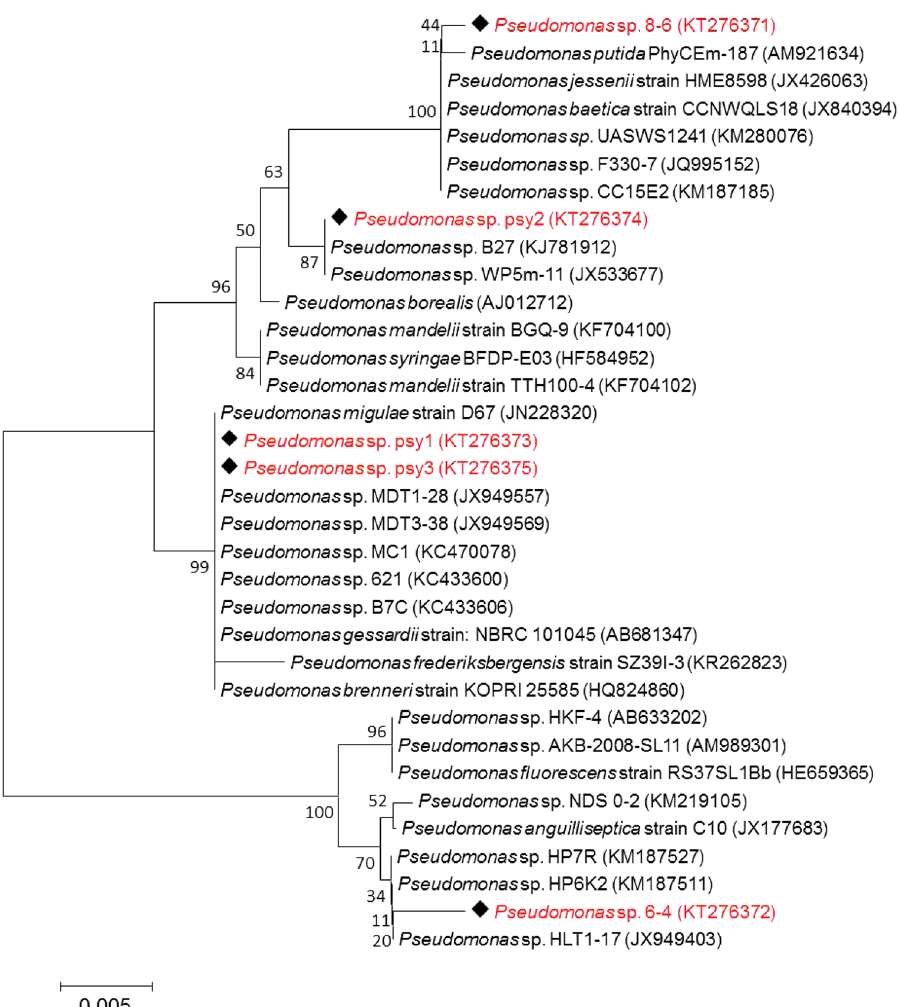
Figure 2. Neighbor-Joining (NJ) bootstrapping (100) phylogenetic tree of arctic glacier soil Pseudomonas spp. and their closest NCBI (BLASTn) strains based on the 16S rRNA gene sequences. Phylogenetic trees were developed based on the maximum composite likelihood method using MEGA 6.06